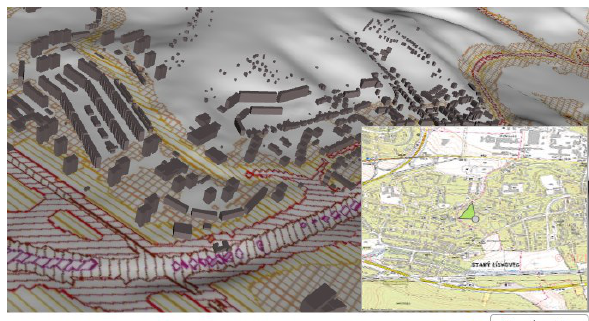
Figure 5. Detail of 3D scene with noise map loaded form WMS and overview map